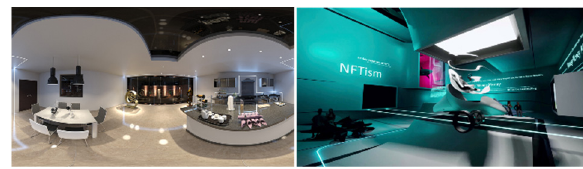
Figure 2. Cases study of NVIDIA Iray and NFTism.